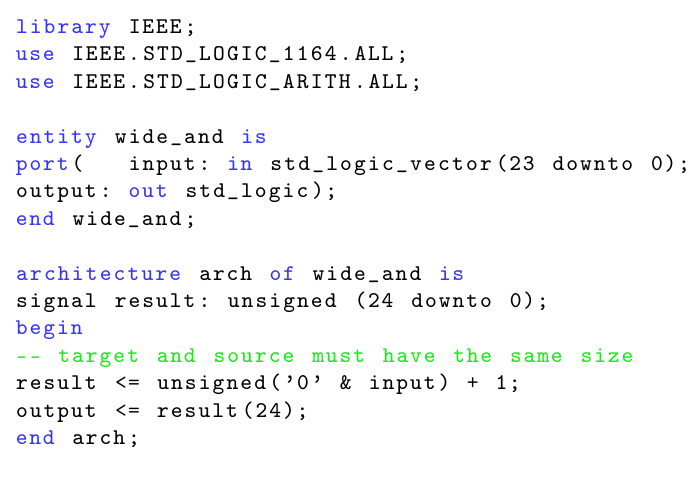
Figure 1. Example of VHDL code for implementing 24-input AND function using carry